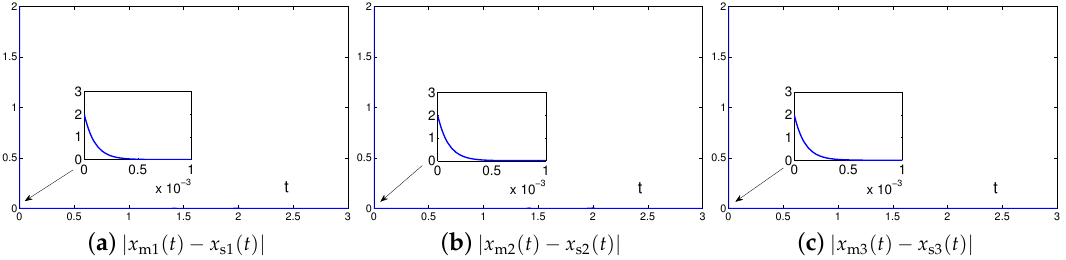
Figure 5. Absolute errors between two identical Lu chaotic systems (24) and (25) equipped with controller (6) via the proposed SEZN approach by choosing design parameter λ = 10 4